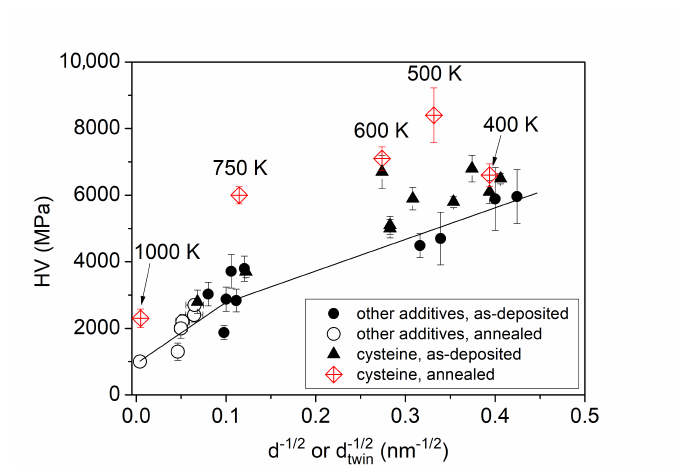
Figure 14. Hall–Petch plot for the films processed with cysteine for both the as-deposited and annealed states. In addition, the hardness values obtained on Ni films processed with other additives (e.g., saccharin and trisodium citrate) are also shown for comparison. from Ref. [9]. The two straight lines for grain sizes smaller and larger than 100 nm were obtained by fitting to the data determined for the Ni films processed with additives other than cysteine (published in